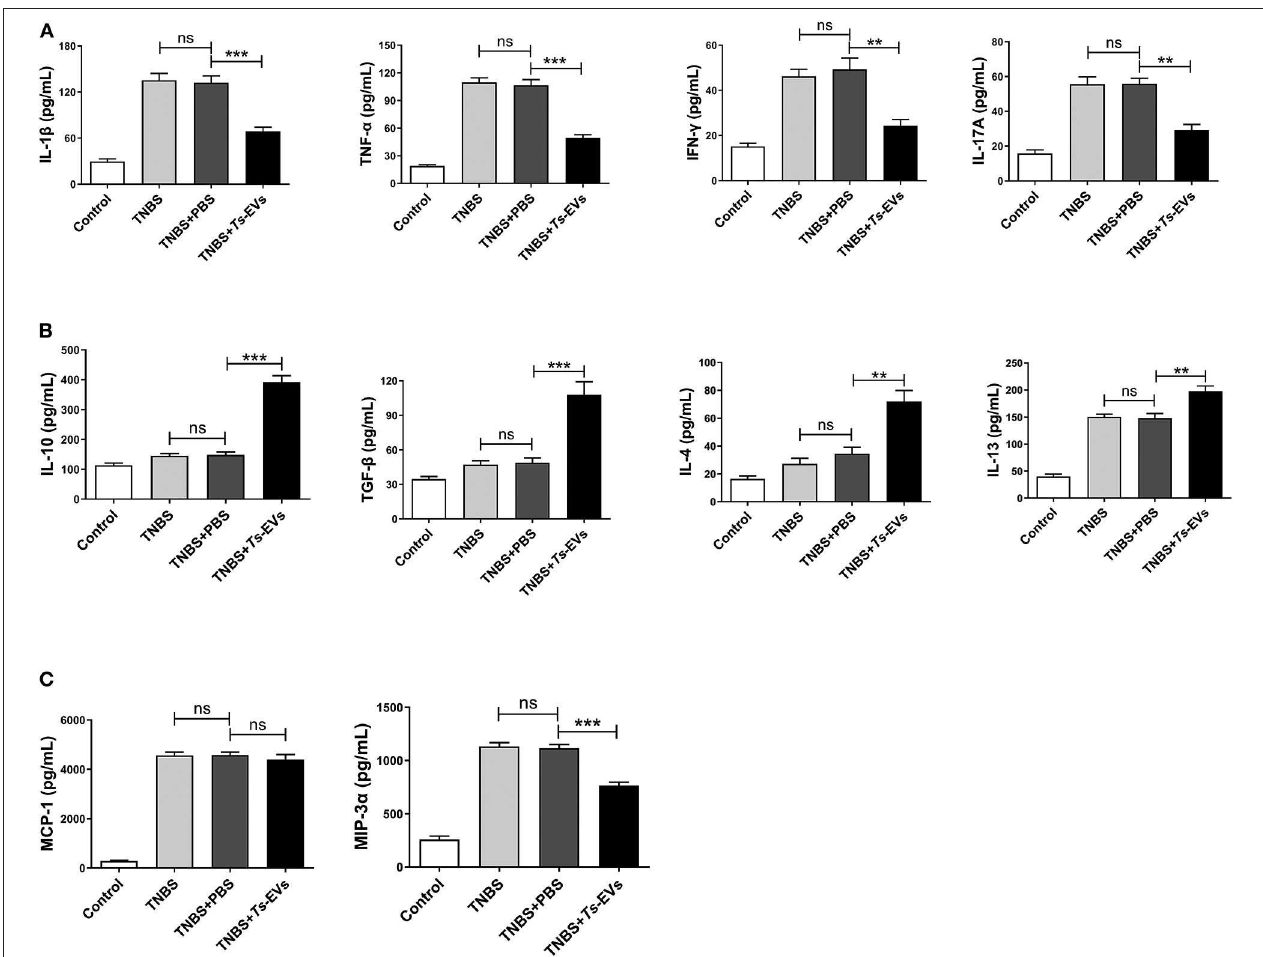
FIGURE 5 | Levels of cytokines and chemokines in colons of mice with TNBS-induced colitis pretreated or not with Ts -EVs. Cytokines levels in homogenized colon tissue supernatants were determined by MSD. (A) Expression levels of Th1 cytokines (IL-1 β , IFN- γ , and TNF- α ) and a Th17 cytokine (IL-17A). (B) Expression levels of Th2 cytokines (IL-4 and IL-13) and regulatory cytokines (IL-10 and TGF- β ). (C) Expression levels of chemokines (MCP-1 and MIP-3 α ). Results are shown as mean ± SD of each group ( n = 3). Statistical analysis was performed with one-way ANOVA followed by Tukey’s multiple-comparison test. ** p < 0.01, *** p < 0.001.